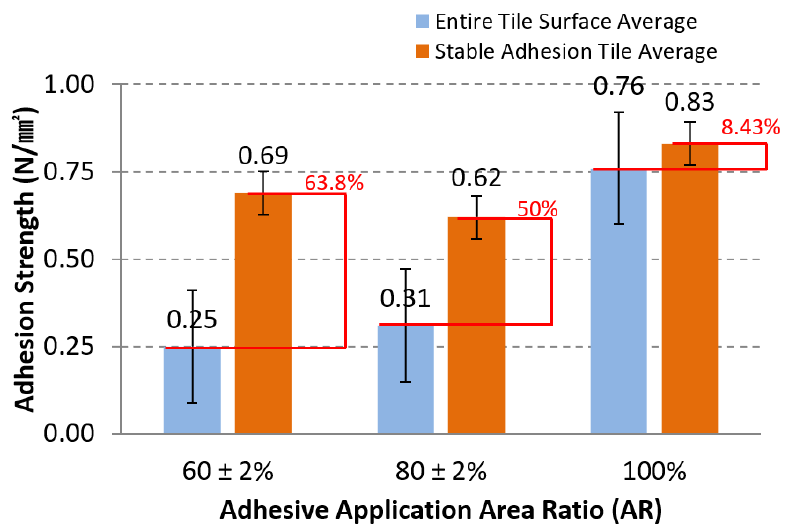
Figure 19. Adhesion strength difference between the averaged and individual adhered pieces rela- tive to the common adhered points. to the common adhered